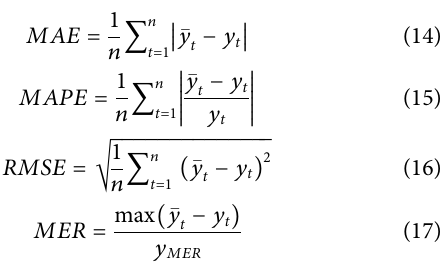
algorithm error. MAPE re fl ects the ratio between the real data